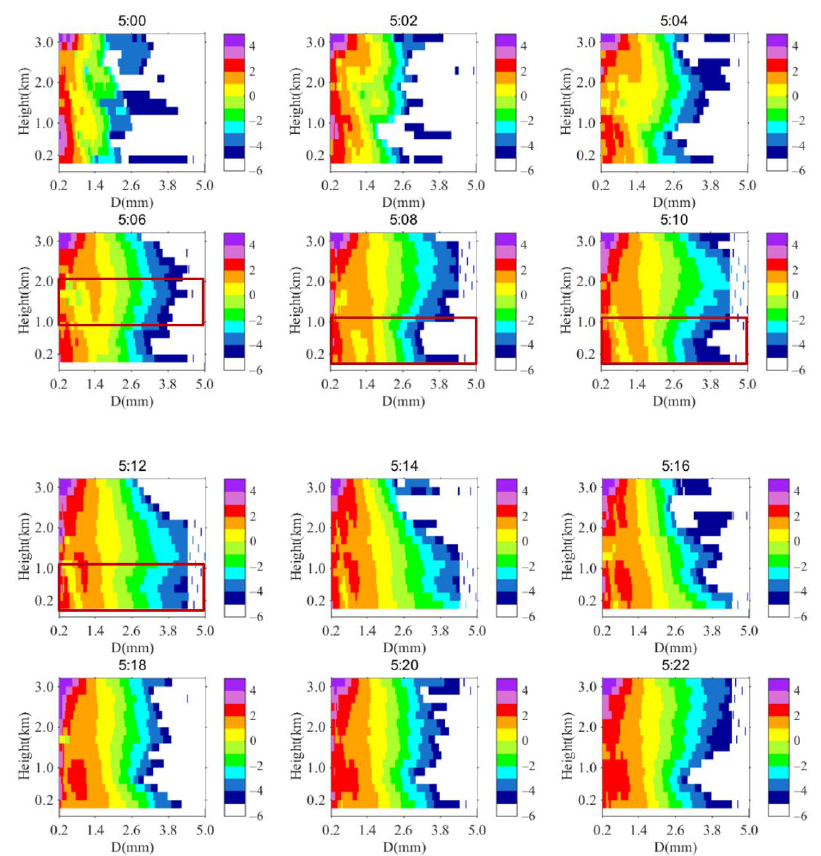
Figure 10. Vertical evolution of DSD every 2 min detected by MRR below 0 °C layer between 5:00 and 5:22 on 19 August 2021.